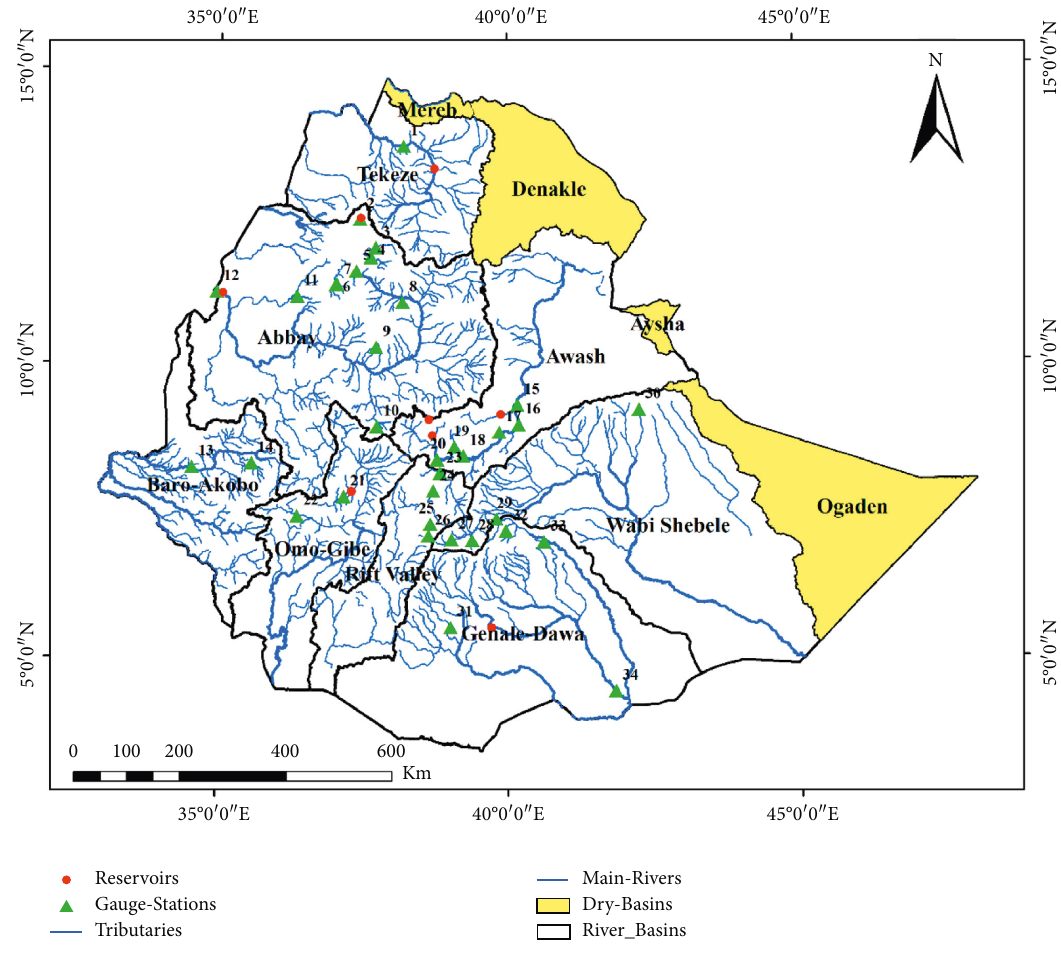
Figure 2: Location of streamflow